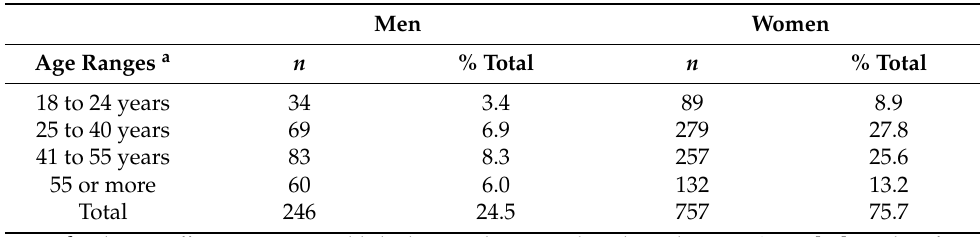
Table 1. Sociodemographic